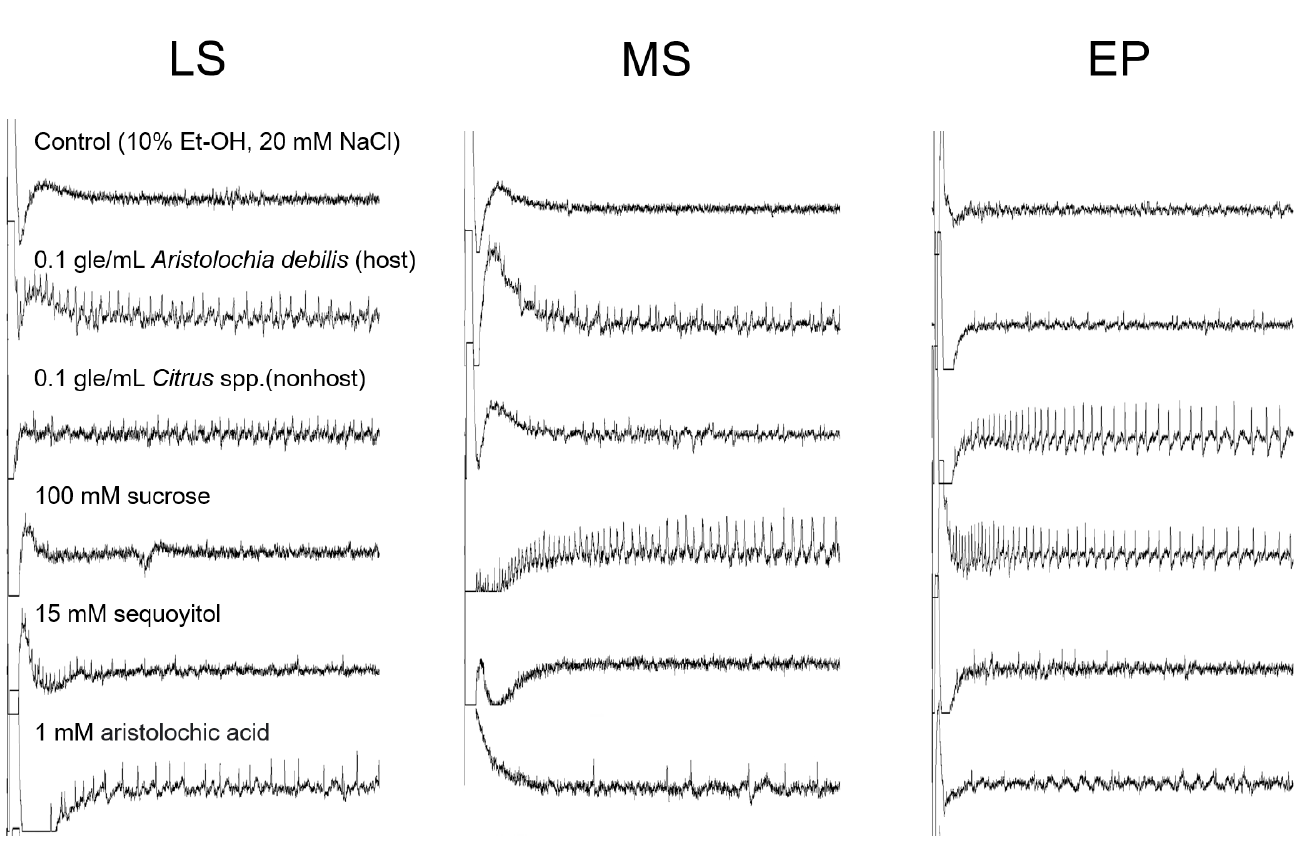
Figure 7. Electrophysiological responses to stimulants from larval sensilla. Individual responses covered 0.5 s after stimulus onset. LS: lateral styloconic sensilla; MS: medial styloconic sensilla; EP: epipharyngeal sensilla. “gle/mL” indicates gram leaf equivalent in 1 mL of control solution.